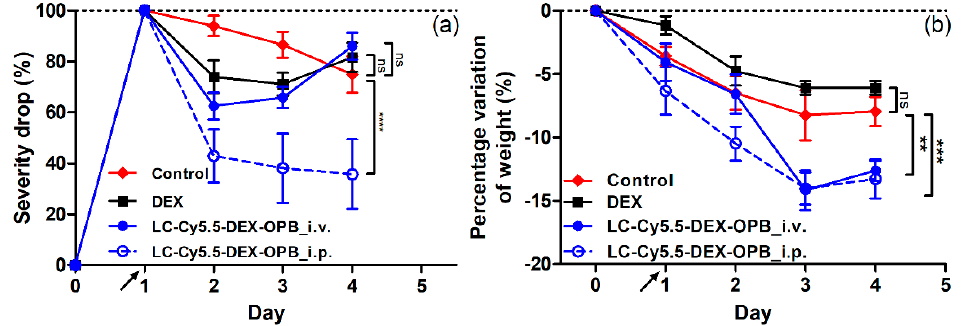
Figure 7. Decrease of the CS of the inflammation of mice in the ankle ( a ) and decrease of the weight of the mice in the therapeutic experiment with dosing 1 × 3 mg DEX-OPB / kg. n = ( b ) of the mice in the therapeutic experiment with dosing 1 × 3 mg DEX-OPB/kg. n = 6. The second dosing regimen (3 × 1 mg DEX or DEX-OPB/kg i.v. or i.p. daily) was more successful